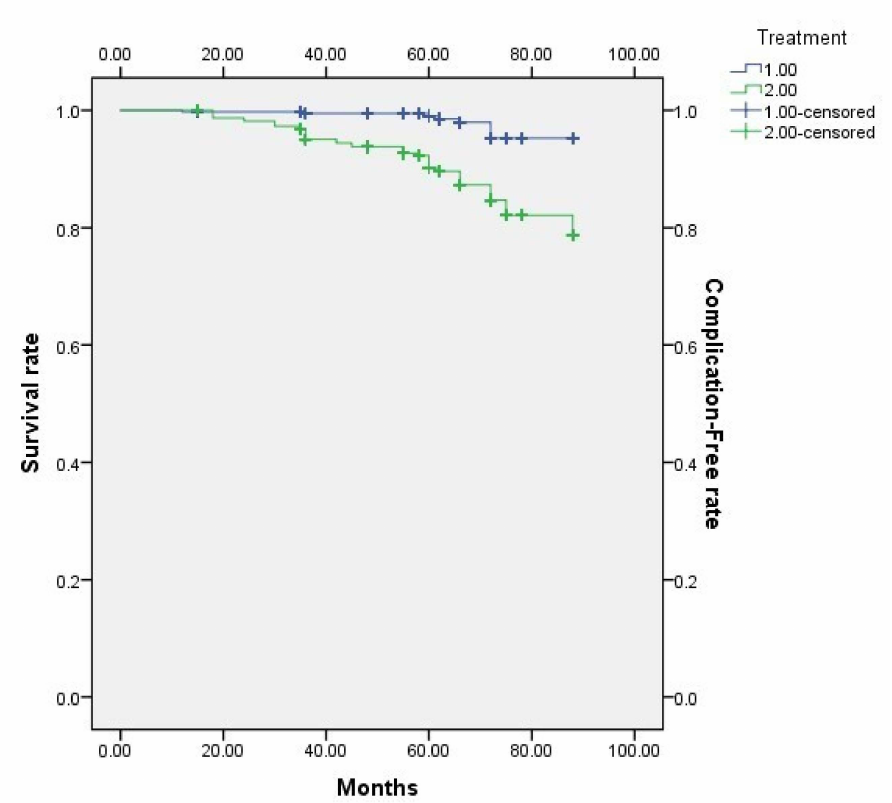
Figure 8. Kaplan–Meier overall survival rate combined with the complications that